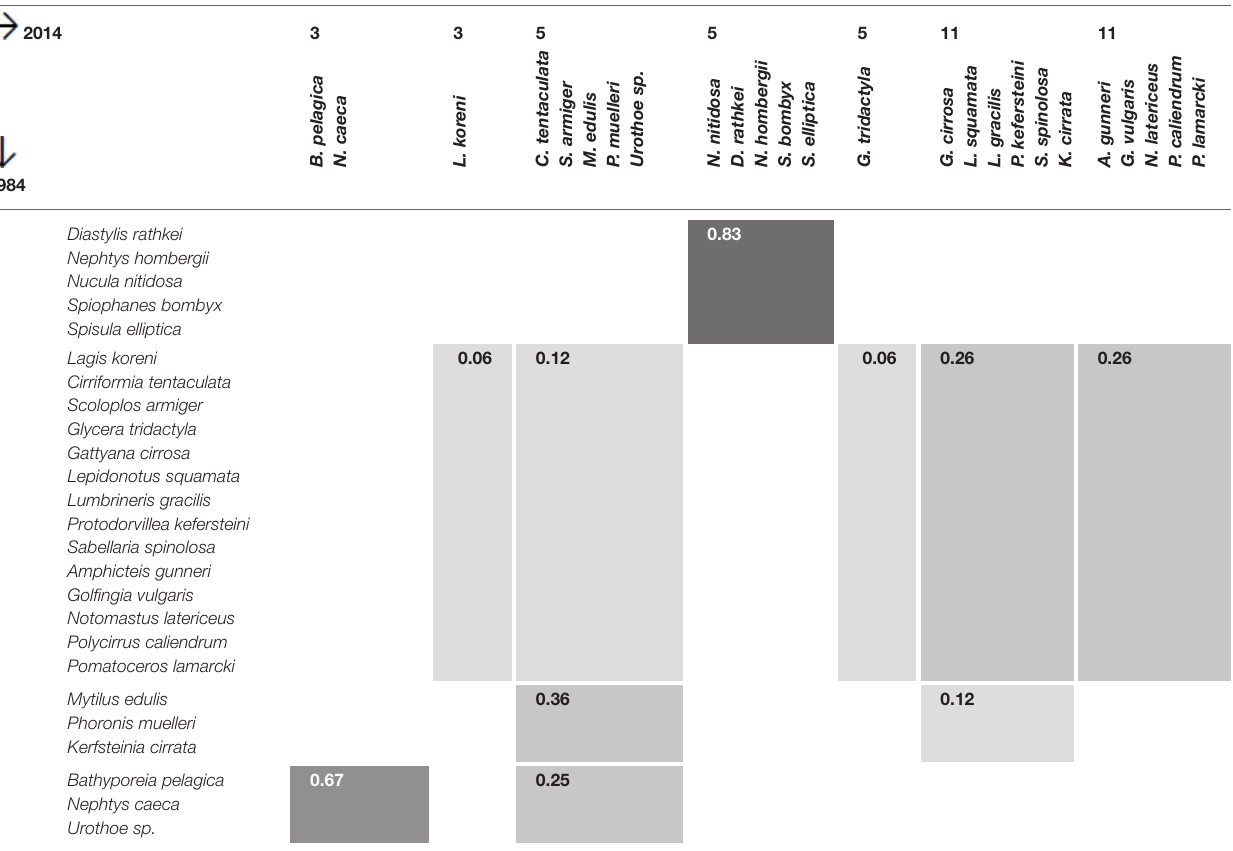
TABLE 4 | Similarity of species associations in 1984 and 2014 (Sørensen